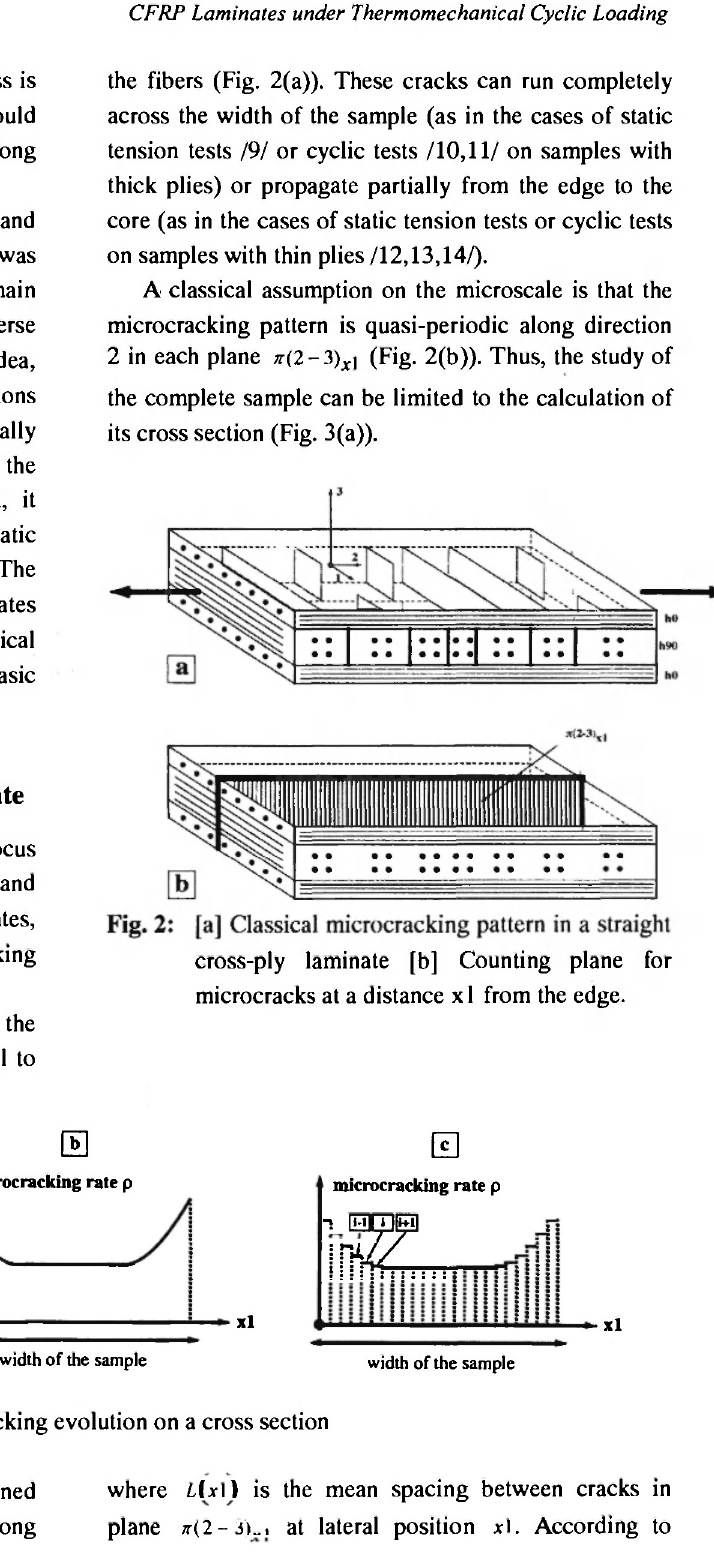
Fig. 3: Microcracking evolution on a cross